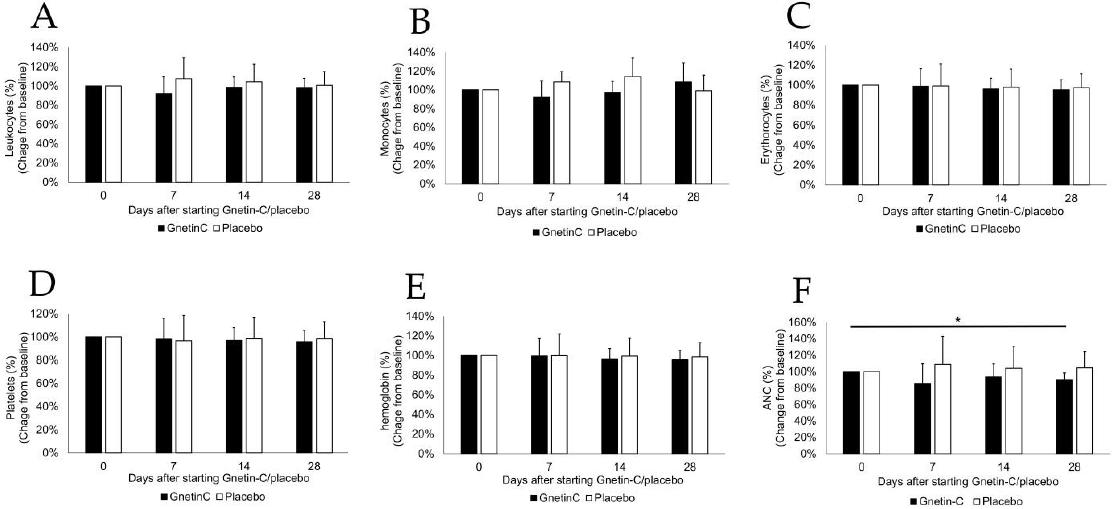
Figure 3. The e ff ects of Gnetin-C on whole blood cell counts. No significant changes were noted in the numbers of ( A ) leukocytes; ( B ) monocytes; ( C ) erythrocytes; or ( D ) platelets; or ( E ) in the hemoglobin concentration, in association with the Gnetin-C intake. However, ( F ) Gnetin-C administration resulted in a significant decrease in the absolute neutrophil count (ANC) in the blood.